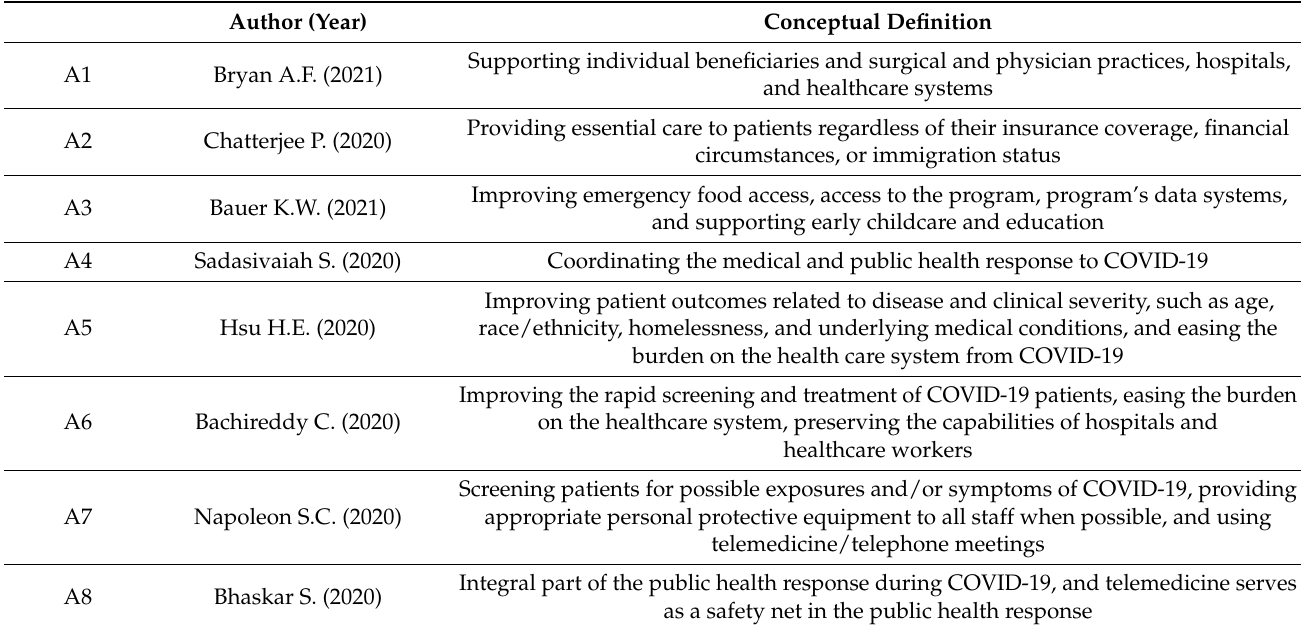
Table 1. A literature review of the healthcare safety